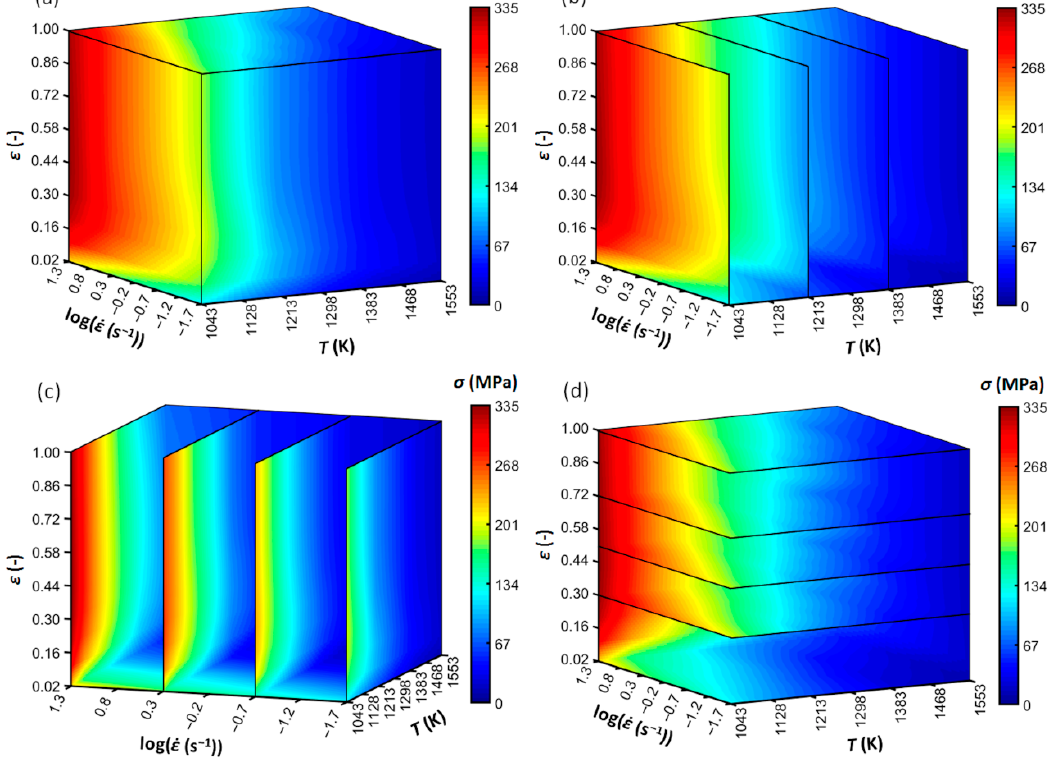
Figure 4. Volumetric expression of the experimental-predicted flow curve datasets of the Cr-Mo low- alloyed steel. Colors–flow-stress level. ( a ) Global overview; ( b ) sliced in the temperature axis; ( c ) sliced in the strain rate axis; ( d ) sliced in the strain axis.